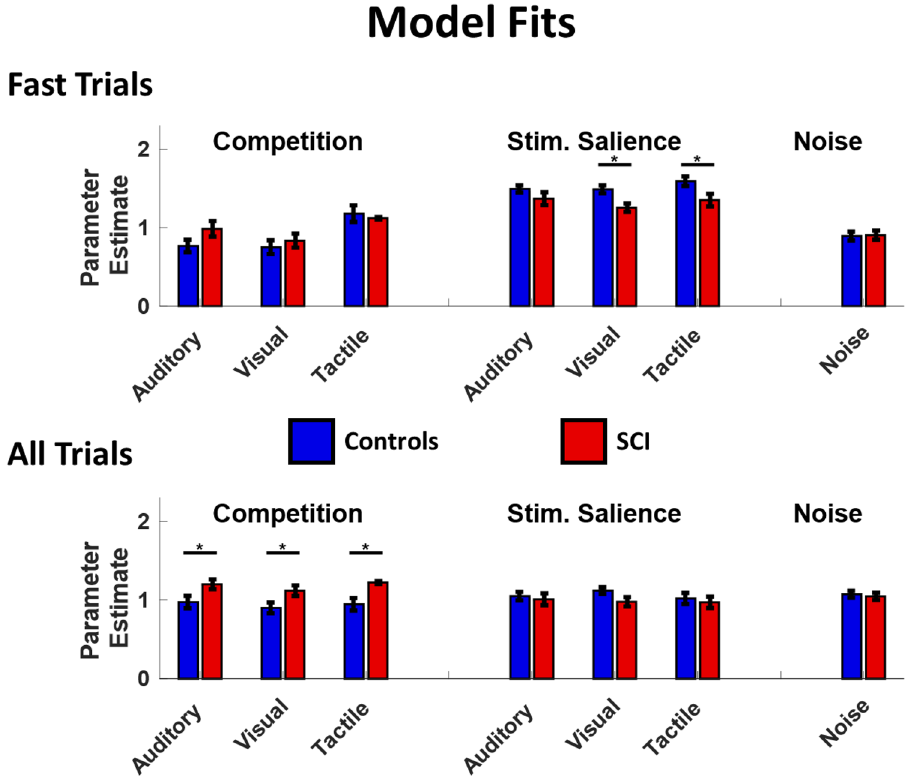
Figure 7. Parameter estimate: Figure shows parameter estimate for both fast trials (panel above) and slow trials (panel below) in each of the model tested (competition, stimulus salience and noise). Blue bars indicate control subjects and red bars indicate subjects with SCI. (Error bars indicate the standard error of the mean; * p <